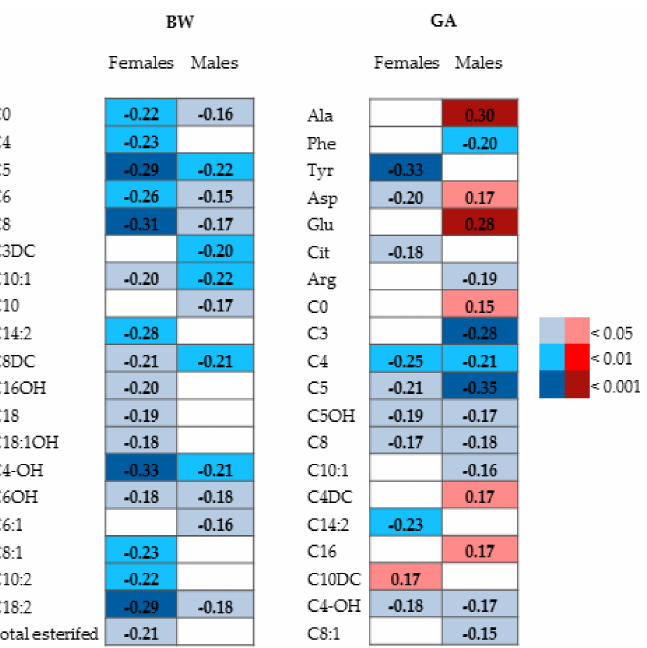
Figure 4. Heat maps of correlations among BW or GA in female and male neonates. Values represent the Spearman’s correlation coefficients. The red and blue colors of the cells indicate positive and negative statistically significant correlation,